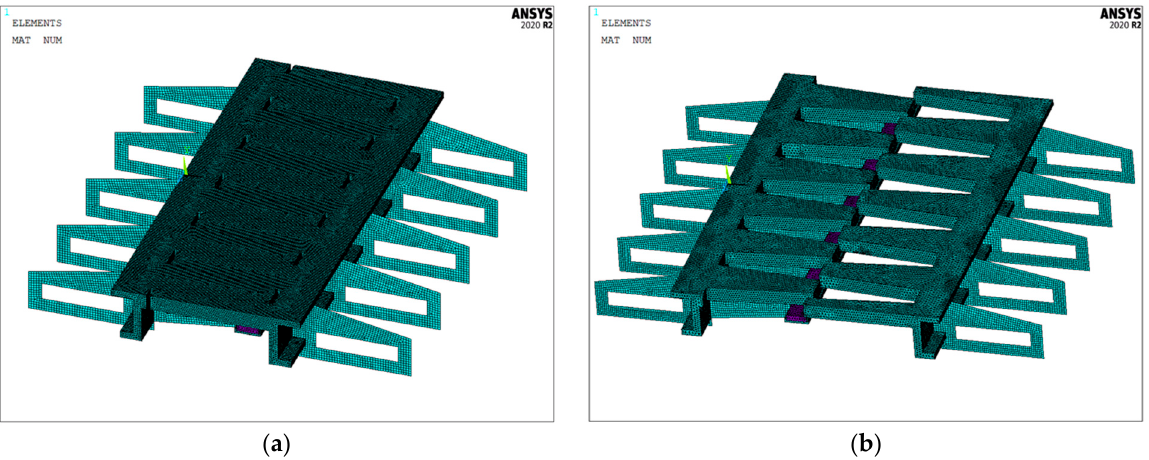
Figure 5. The finite element meshing for working conditions: ( a ) working condition I, ( b ) working condition II.